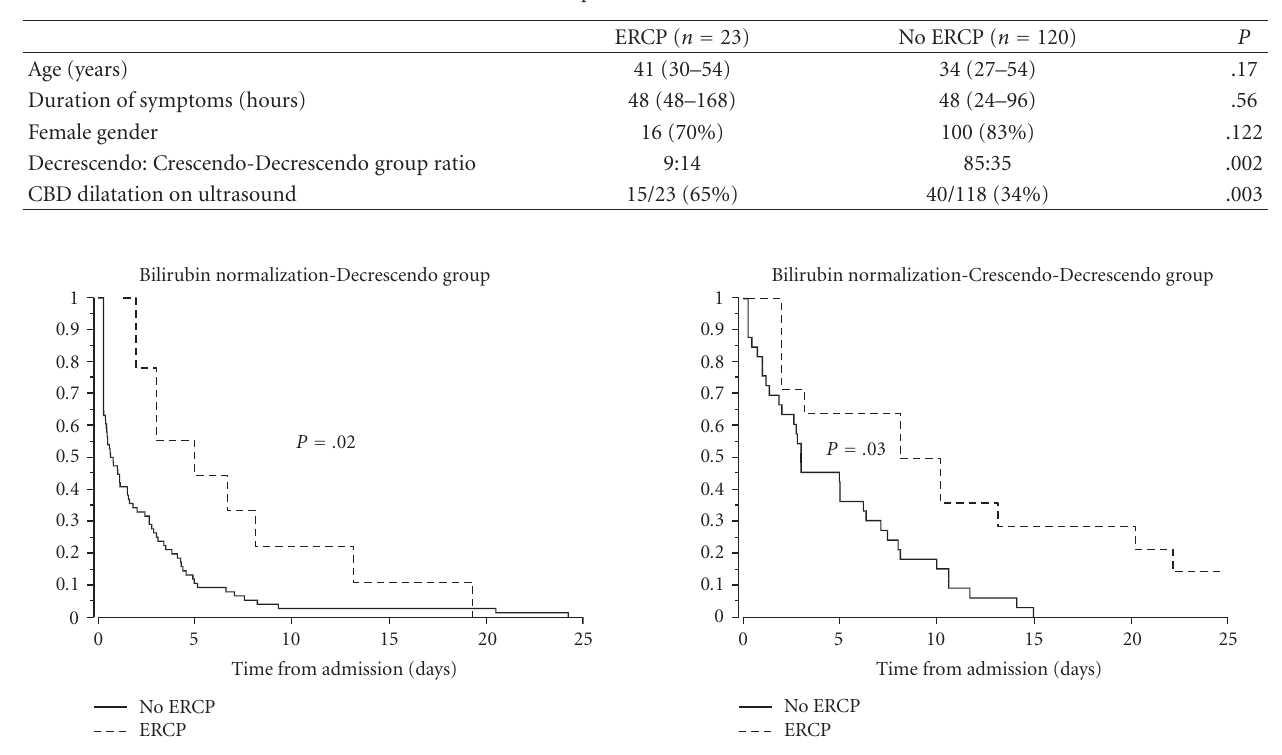
Table 2: Characteristics in those patients who underwent ERCP versus no ERCP.